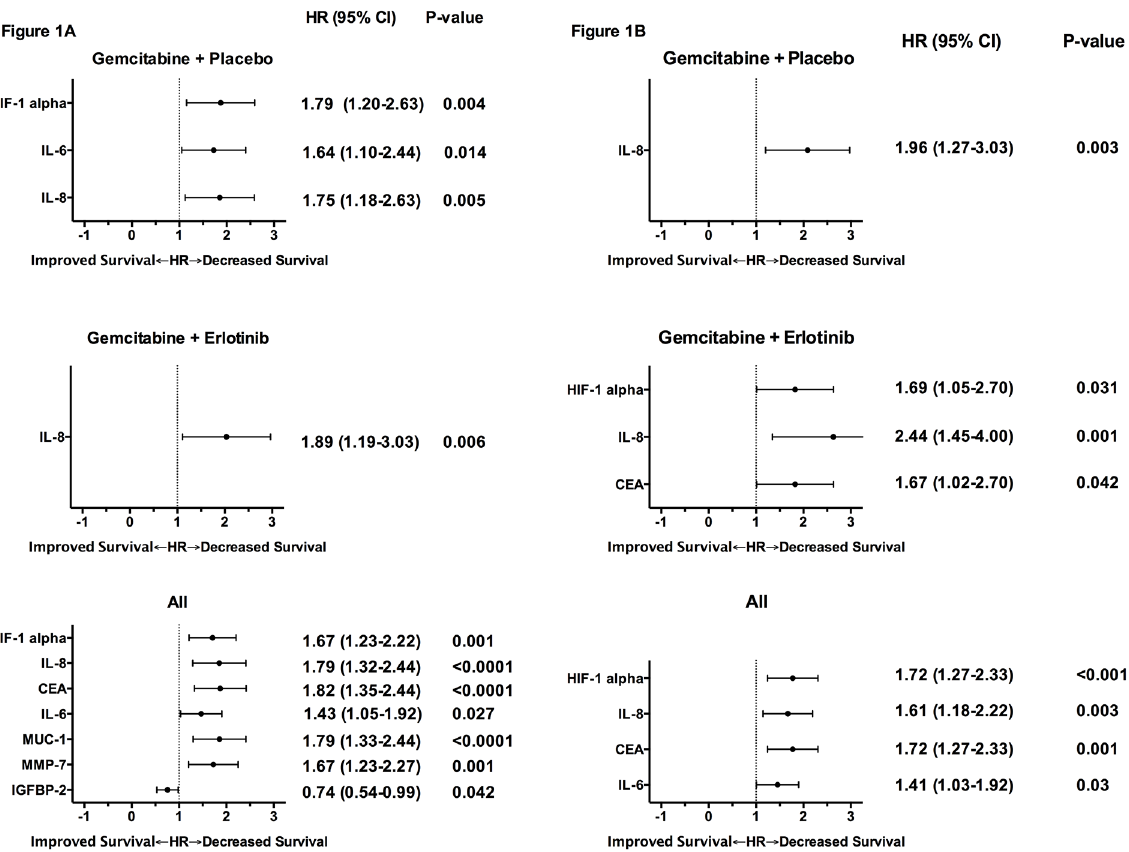
Fig 1. Univariate (A) and multivariable (B) analyses of the association between biomarker concentration, according to median levels, and overall survival. Hazard ratios (HR) (of high to low biomarker concentration) and p-values are shown for biomarkers that were significantly associated (p < 0.05) with survival. Results shown are from the validation